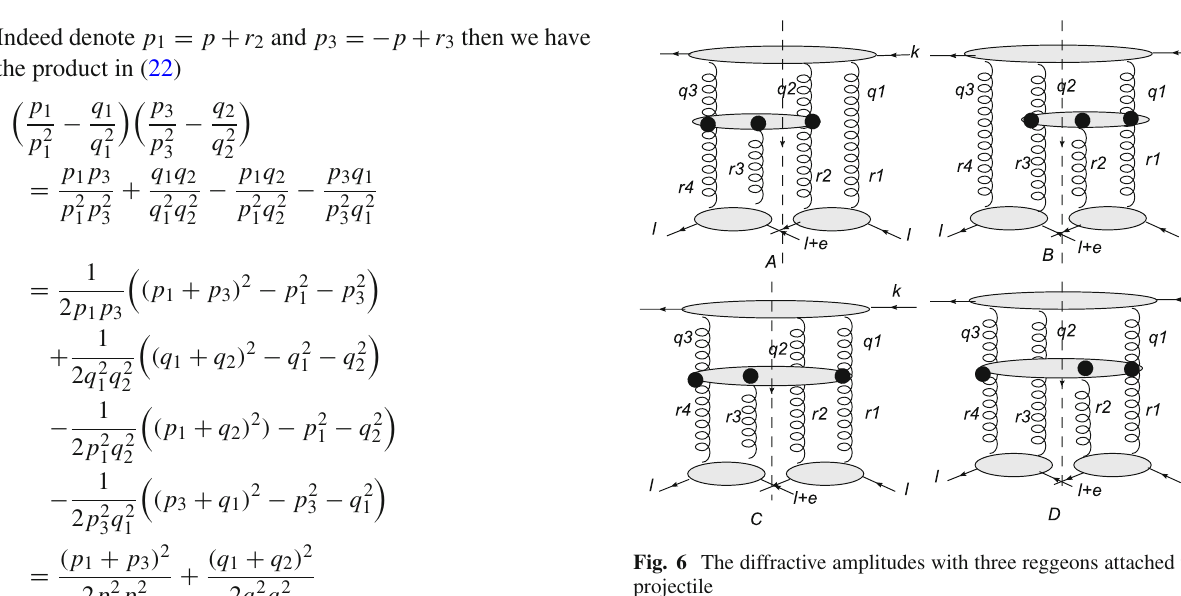
it depends on q 1 + , q 2 + , r 1 − and r 4 − . As before one has r 1 + r 2 = − r 3 − r 4 = e with e + =